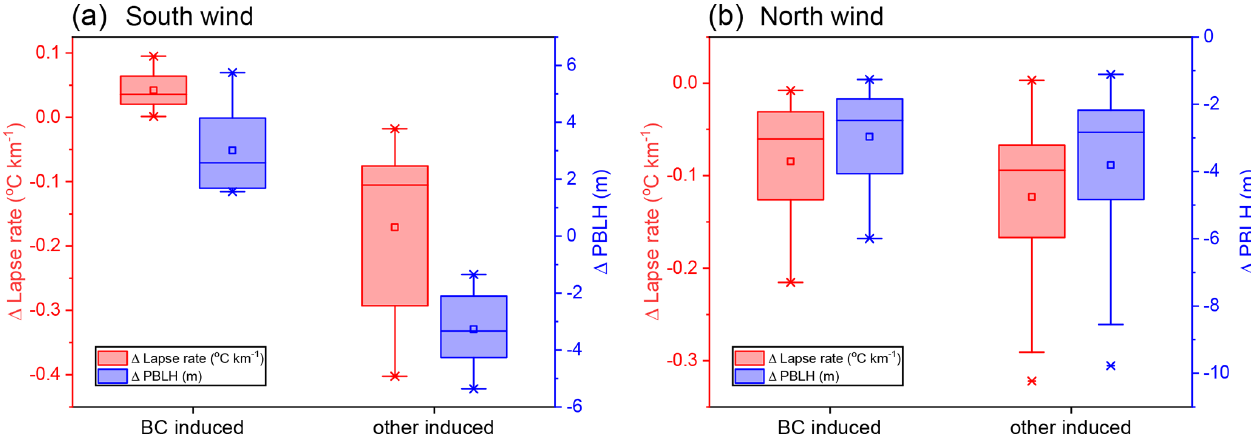
Figure 14. Box plots of the variations in lapse rate within 1.5km and PBLH influenced by the BC and other aerosols under (a) the prevailing southerly wind and (b) the prevailing northerly wind, respectively. The squares represent the mean values, the horizontal lines inside the boxes are the medians, and the bottom and top sides of the boxes represent the first and third quartiles. The whiskers are the minimum (maximum) values within 1.5 interquartile ranges of the lower (upper) quartile. The asterisks indicate the minimum (maximum)